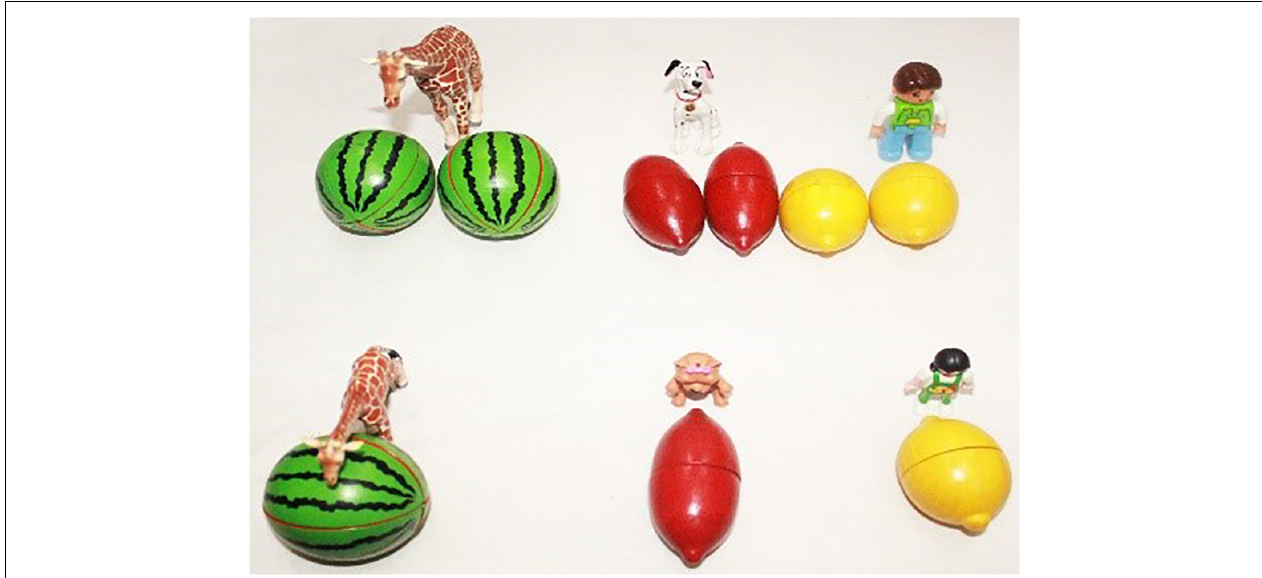
FIGURE 7 | Last scene of the story of the Whole Object